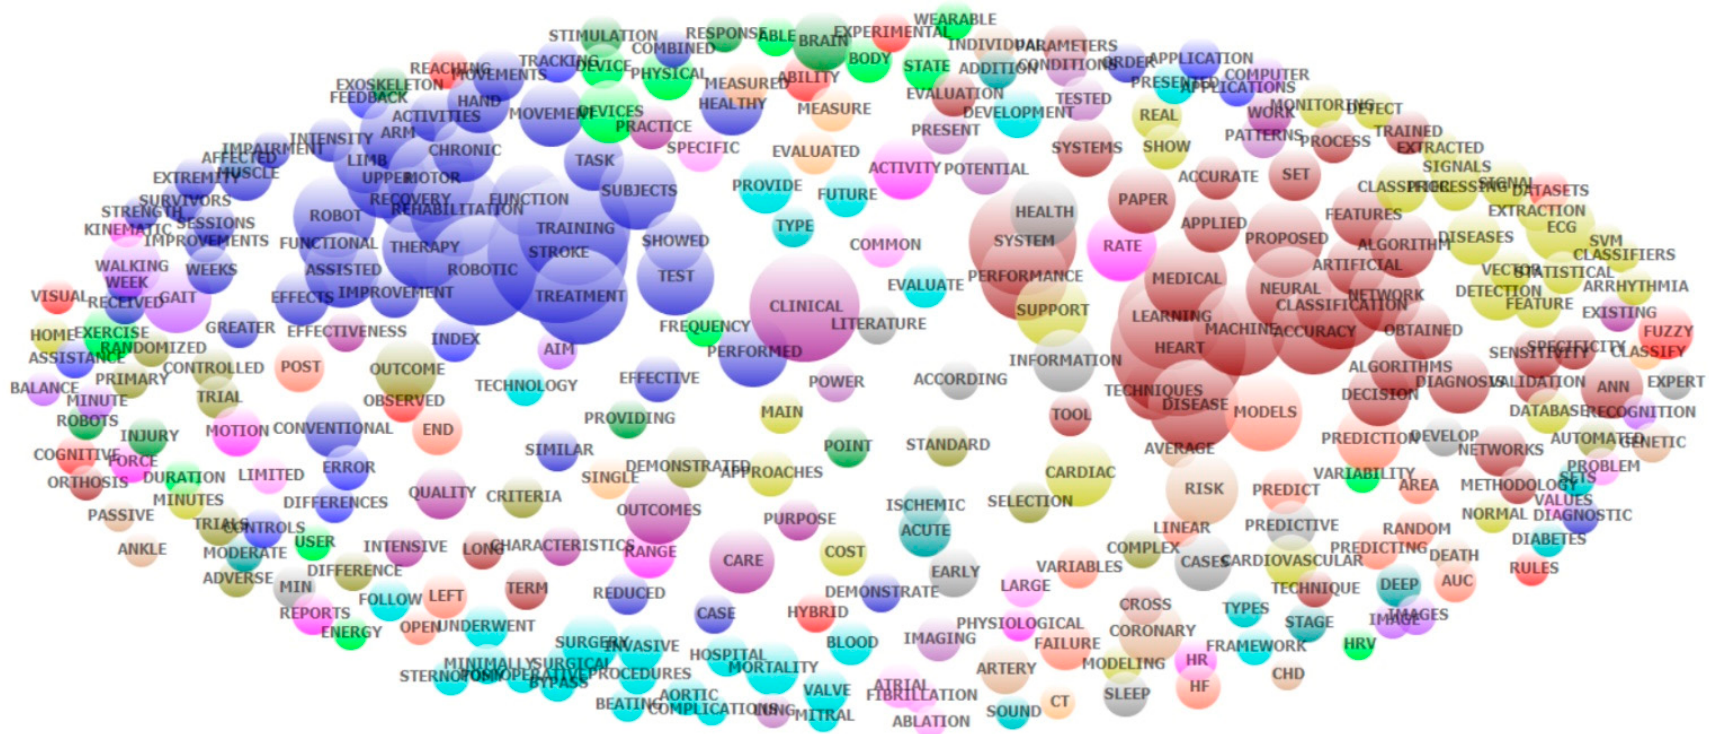
Figure 3. Co-occurrence of the most frequent topics that emerged from the exploratory factor analysis of abstracts contents. (ANN: Artificial Neural Network; AUC: area under the curve; CHD: coronary heart disease; CT: computed tomography; ECG: electrocardiogram; HF: heart failure; HR: heart rate; HRV: heart rate variability; SVM: support vector machine)